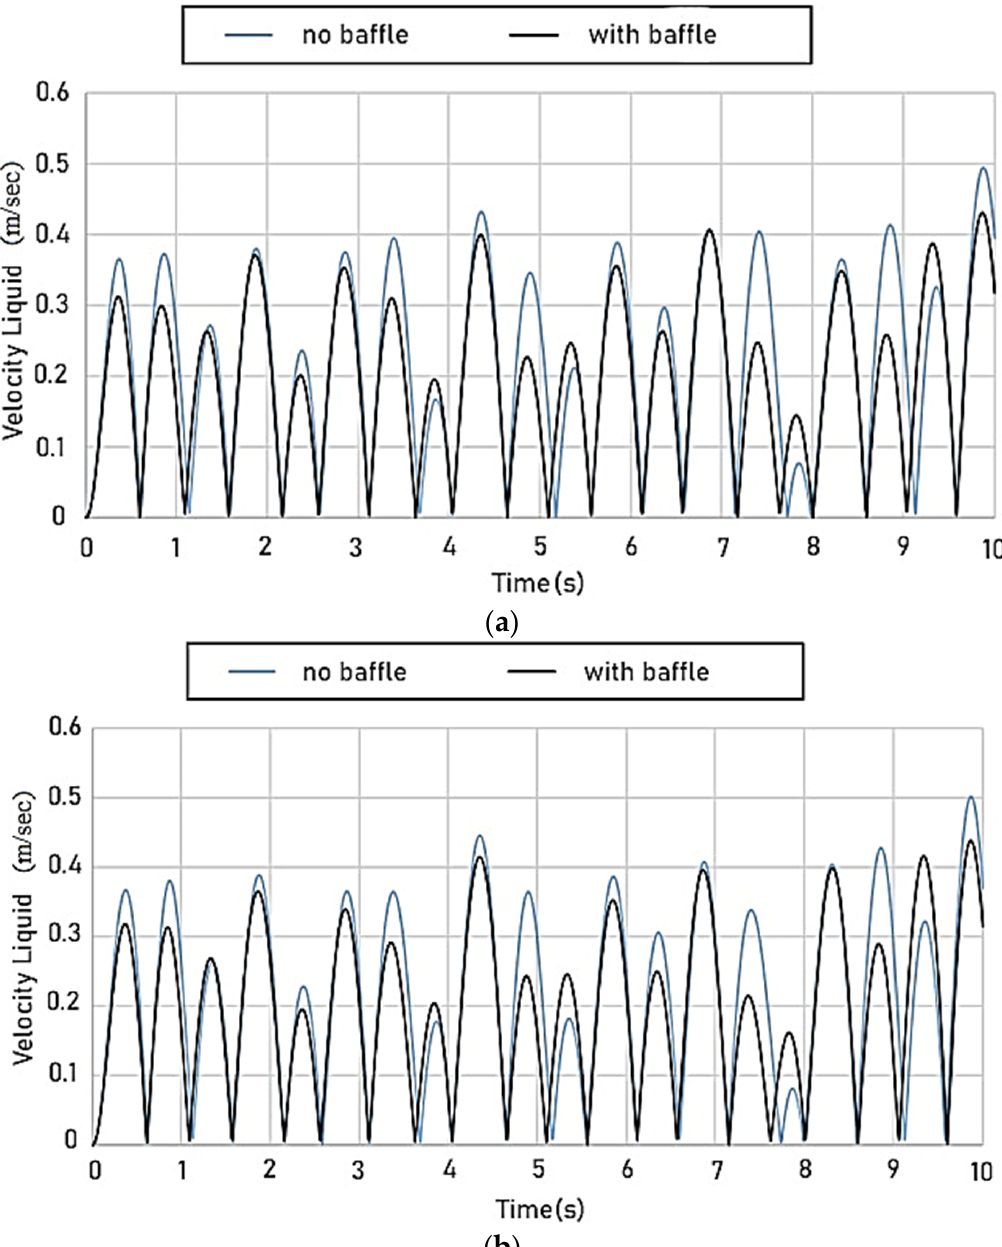
Figure 13. Comparison of fluid velocity sloshing in the tank with and without baffles. ( a ) Fluid velocity sloshing with/no baffle at point 6; ( b ) fluid velocity sloshing with/no baffle at point 7. The effect of baffles on the frequency content of the tank is investigated, as shown in Figure 14. Changes in the fluid surface height are shown at frequencies ω = 1~4 Hz for the three cases: a tank with no baffle, a tank with a horizontal baffle, and a tank with an annular baffle. In Table 5, the fluid surface sloshing height reductions at frequencies 1 to 4 Hz are compared in the cases with baffles (horizontal and annular) and with no baffles. According to the figures and tables, using a baffle decreases the height of free-surface turbulence in the tank. Meanwhile, the results confirm that the annular baffle leads to more reduction in the free-surface turbulence height than the horizontal baffle. It is noteworthy to mention that the effect depends entirely on the frequency content of the applied